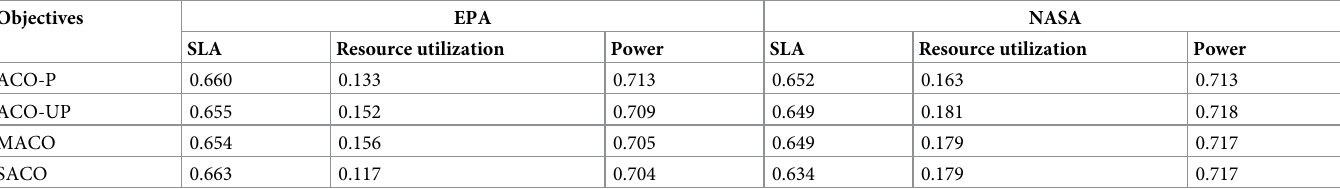
Table 3. The results of the realistic workload by